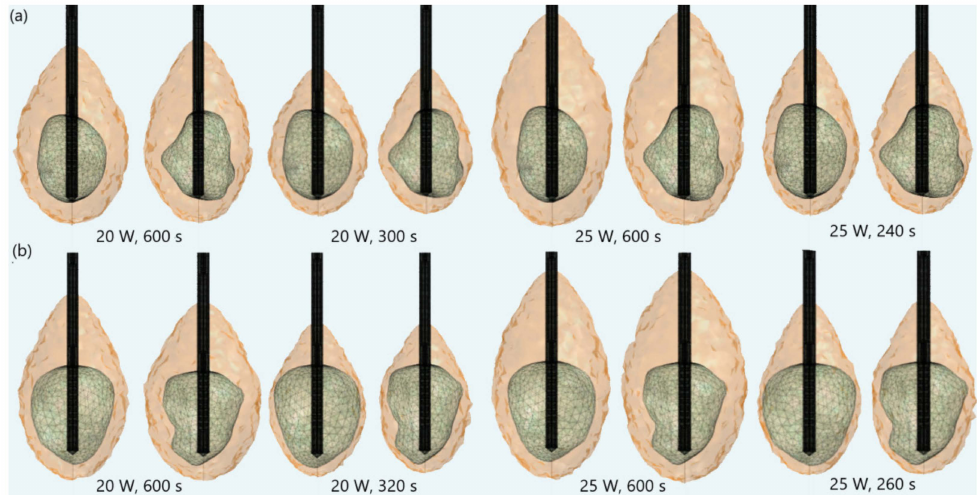
Figure 5. Iso-contours that include the ablated regions (solid light brown surface) around the liver tumor (triangulated surface) ( a ) 1.07 [51] and ( b ) 1.03 [51] when an input power of 20 W or 25 W is applied during various ablation times.